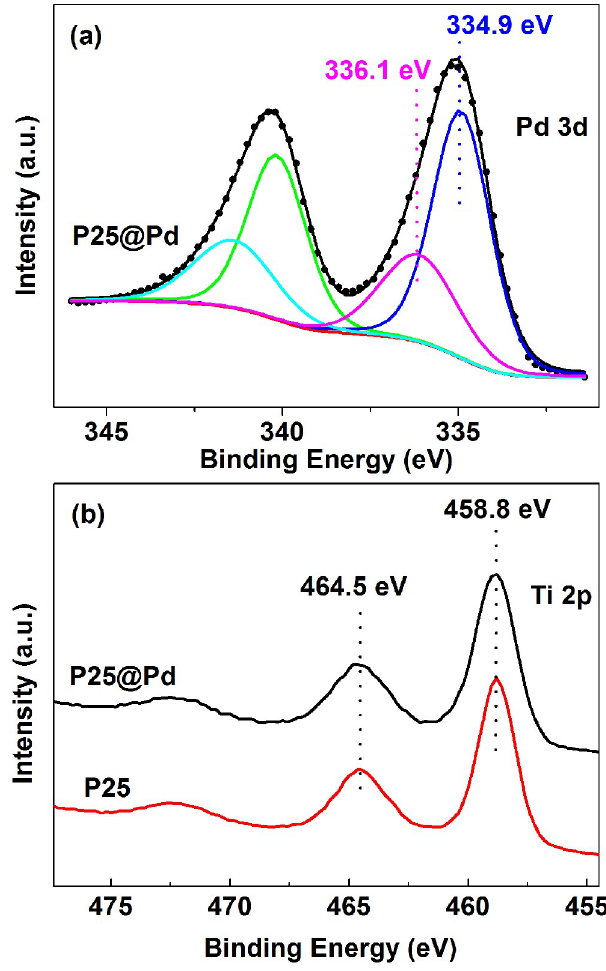
Figure 4. ( a ) X-ray photoelectron spectroscopy (XPS) Pd 3d spectra of P25@Pd core-shell catalyst. Circle symbols are experimental data. Pd 0 peaks at 334.9 eV and 340.2 eV, and Pd δ + peaks at 336.1 eV and 341.4 eV are fitting results. ( b ) XPS Ti 2p spectra of P25@Pd catalyst and P25 support.